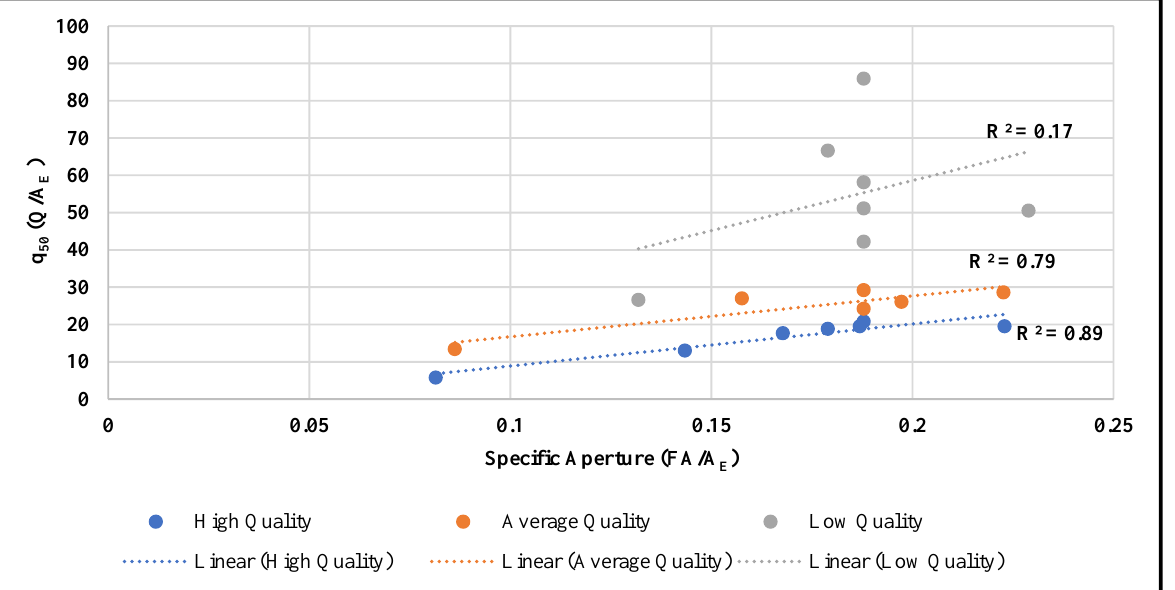
Figure 13. Linear correlation between q 50 and specific aperture across the three different observed categories of observed fenestration quality.